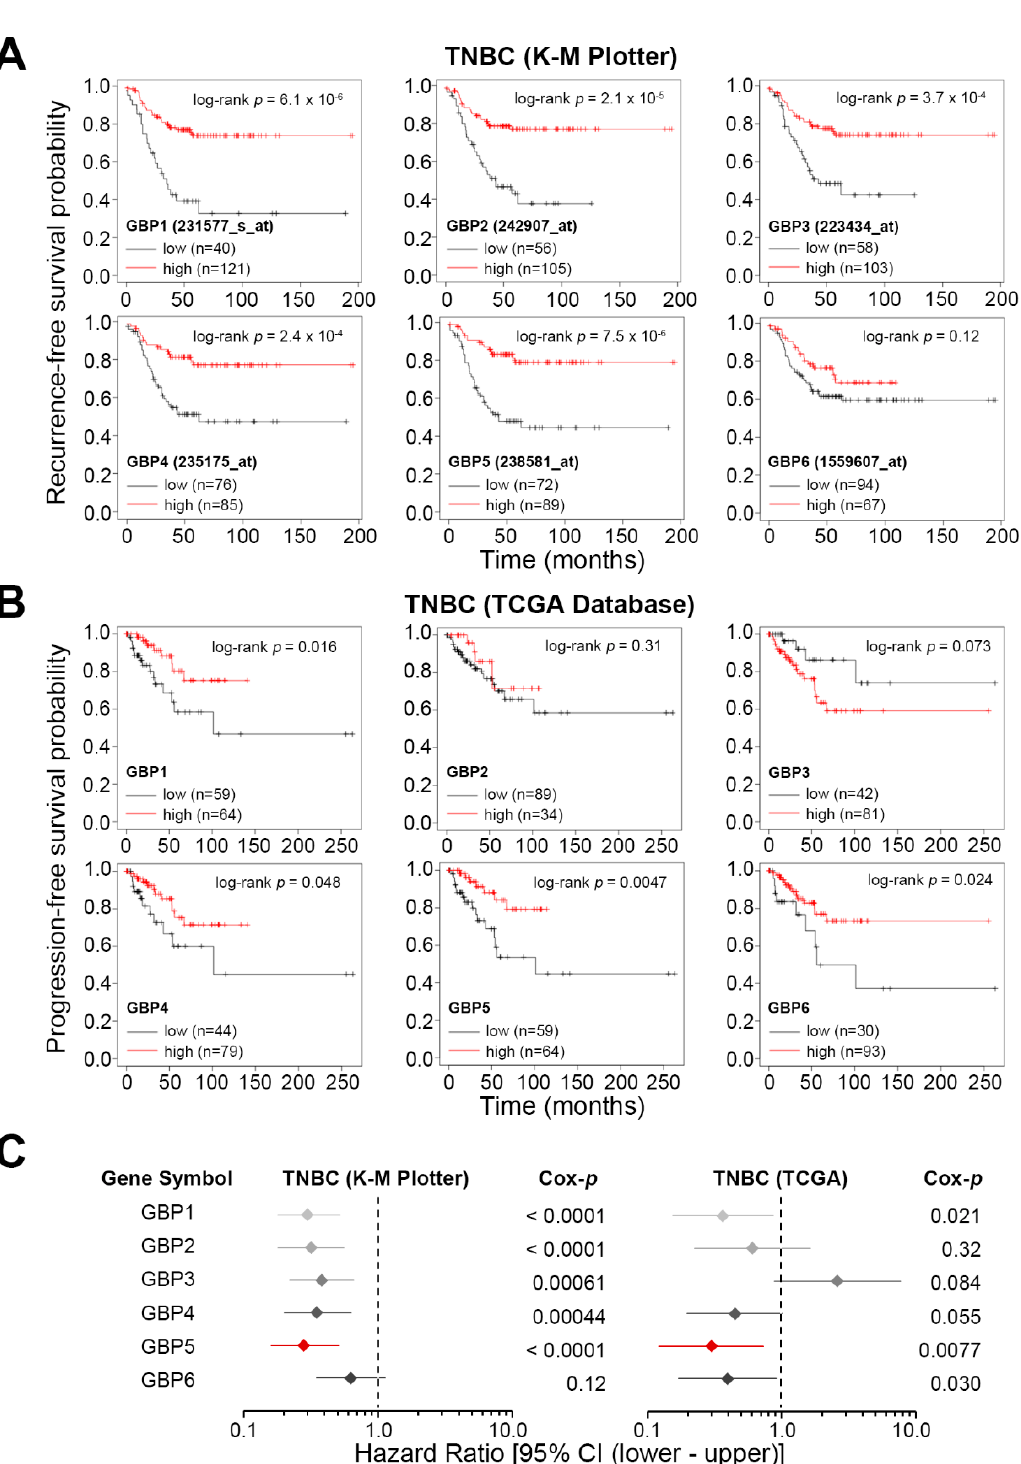
Figure 1. Guanylate-binding protein 5 (GBP5) upregulation predicts a good prognosis in triple-negative breast cancer (TNBC). (A and B) Kaplan–Meier analyses for GBP1, GBP2, GBP3, GBP4, GBP5 and GBP6 gene expression using recurrence-free survival condition against TNBC patients from K–M Plotter ( A ) and progression-free survival condition against TNBC patients from TCGA database ( B ) under a minimized p value. ( C ) Forest plot for the hazard ratio at a 95% confidence interval (CI), derived from Cox regression test using univariate mode for GBP1, GBP2, GBP3, GBP4, GBP5 and GBP6 against TNBC cohorts shown in A and B.